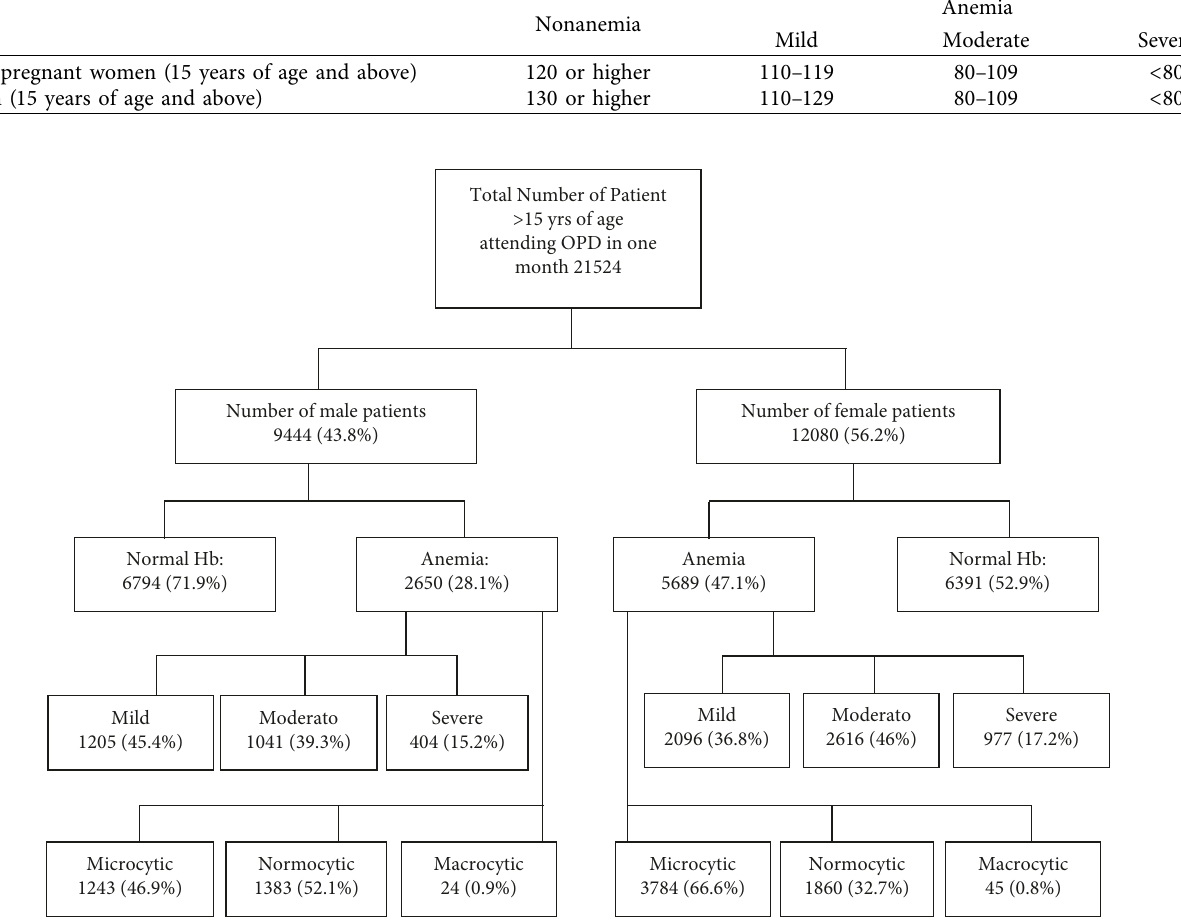
Figure 1: Flow chart showing the patient selection and